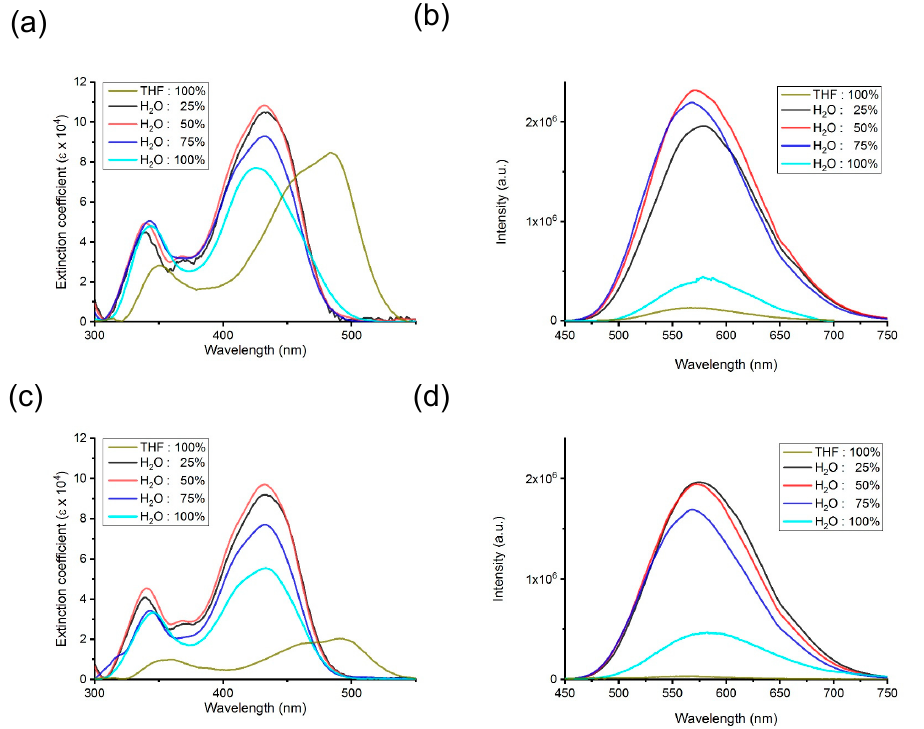
Figure 6. Normalized absorption and fluorescence emission spectra of fluorogens from MeAcd12C ( a , b ) and MeAcd12P ( c , d ). Compounds were dissolved in 0%, 25%, 50%, 75%, and 100% of H 2 O mixing ratios with THF ( v / v ). The corresponding excitation wavelengths were determined from the absorption maxima present in each absorbance spectrum.